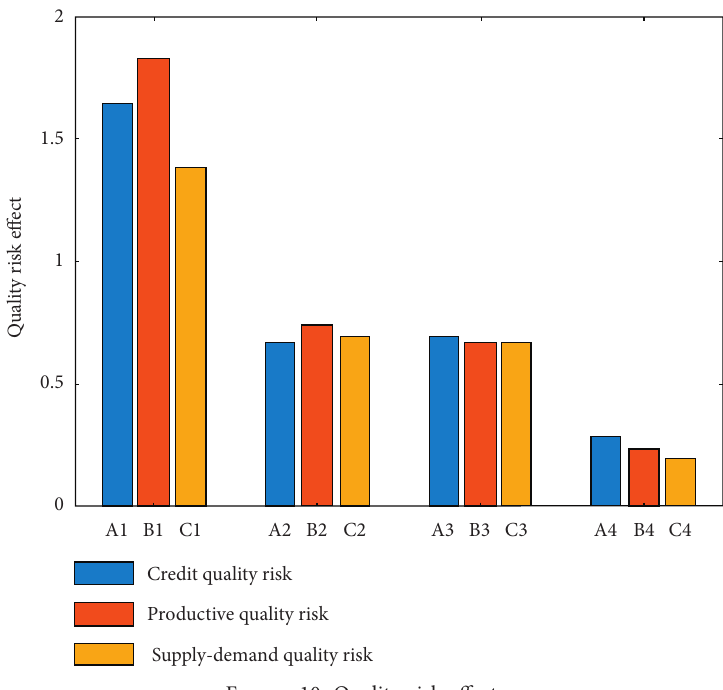
Figure 10: Quality risk